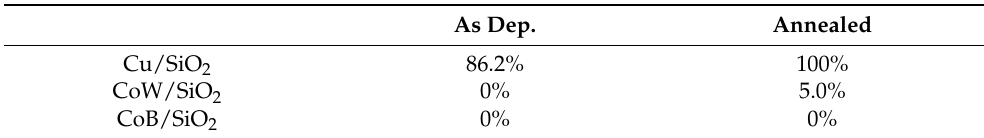
Table 1. Tape test results for Cu/SiO 2 , CoW/SiO 2 , and CoB/SiO 2 before and after annealing at 425 ◦